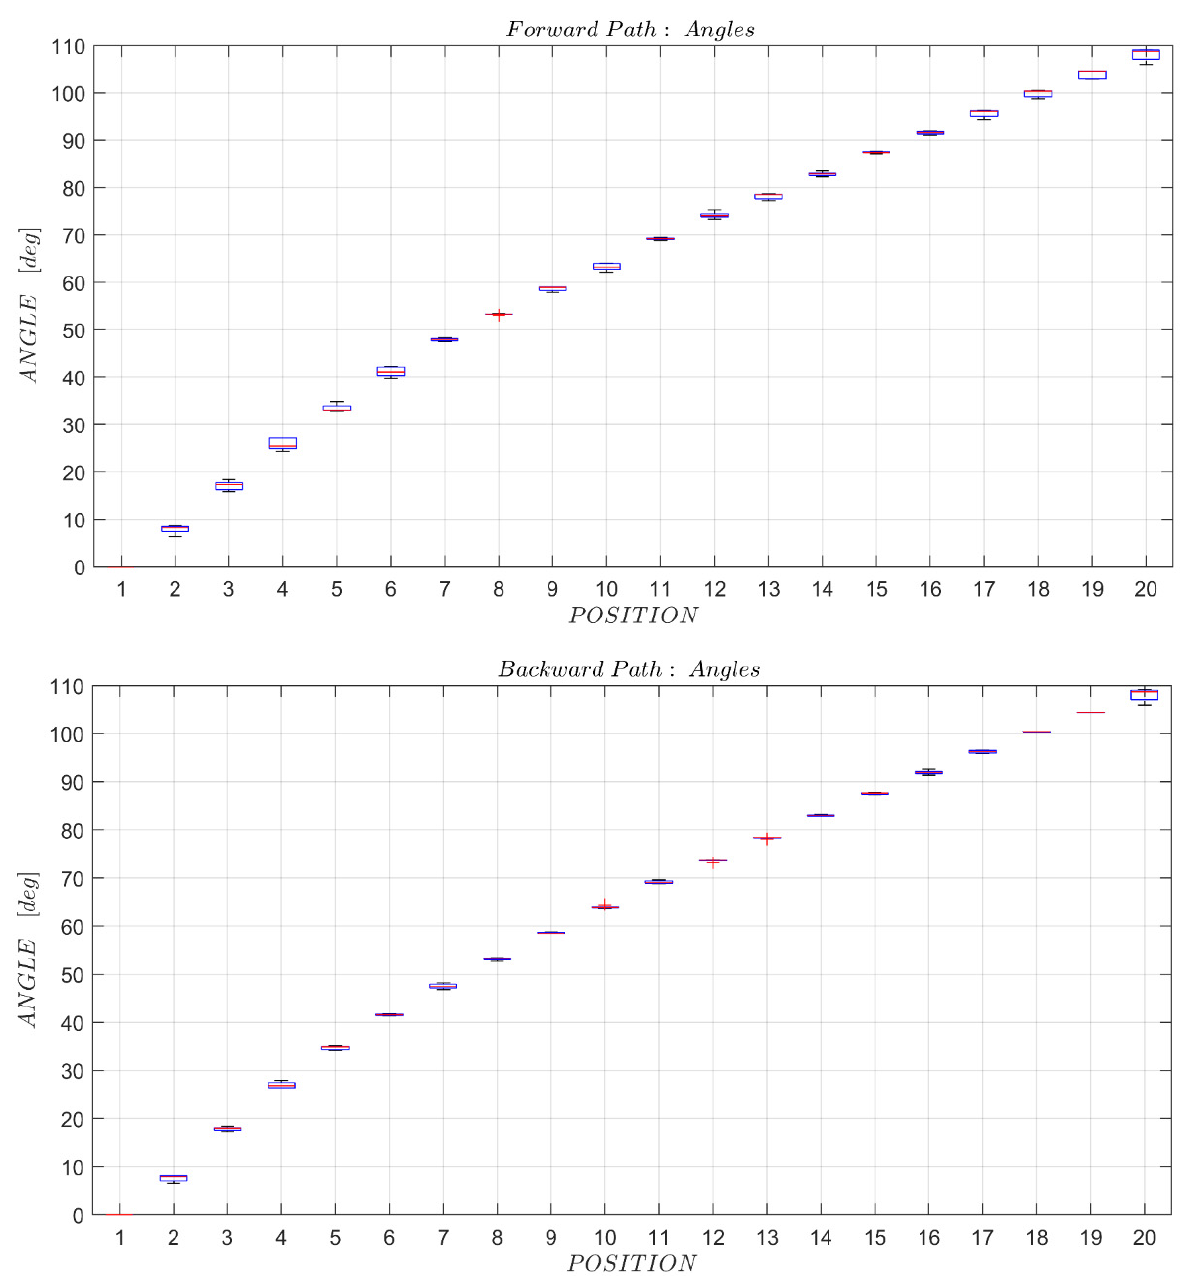
Figure 24. Boxplots of the angle values in the forward and backward paths for the sensor 001 19 22.